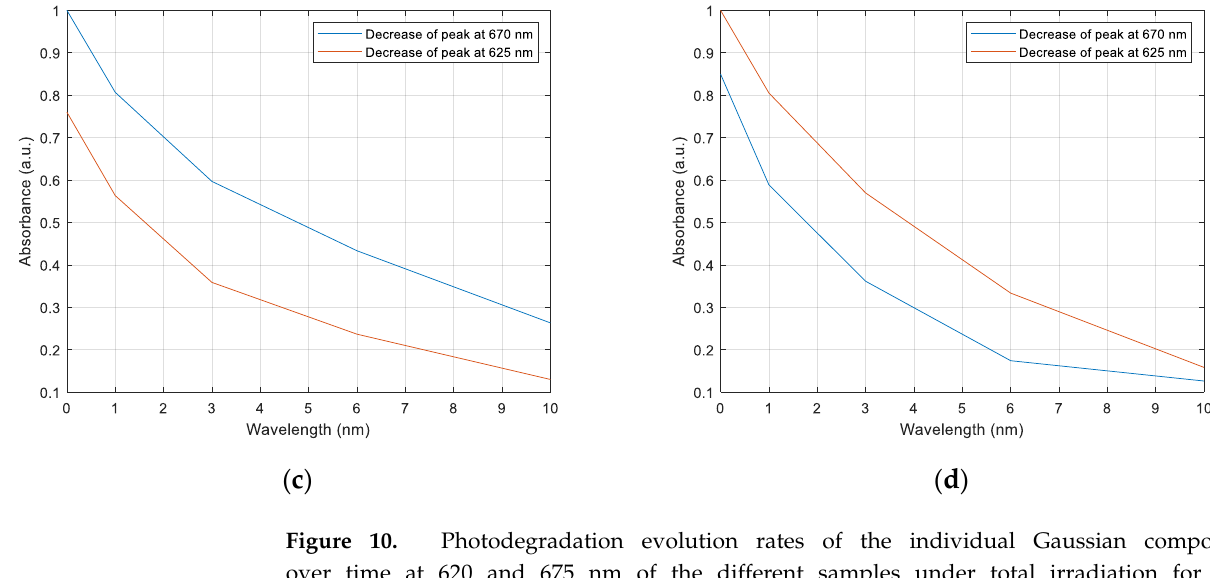
Figure 10. Photodegradation evolution rates of the individual Gaussian components over time at 620 and 675 nm of the different samples under total irradiation for 10 h. ( a ) PAA + β -CD; ( b ) PAA + β -CD//TiO 2 /PAA; ( c ) PAA + β -CD//TiO 2 /PAA + WO 3 ; ( d ) PAA + β -CD//TiO 2 /PAA + Fe 2 O 3 .